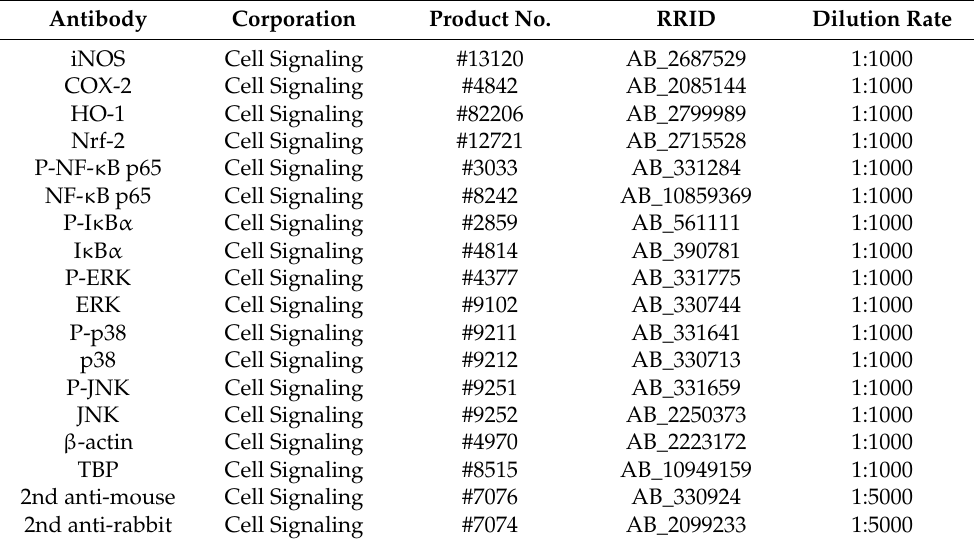
Table 1. Primary and secondary antibodies use for Western blot